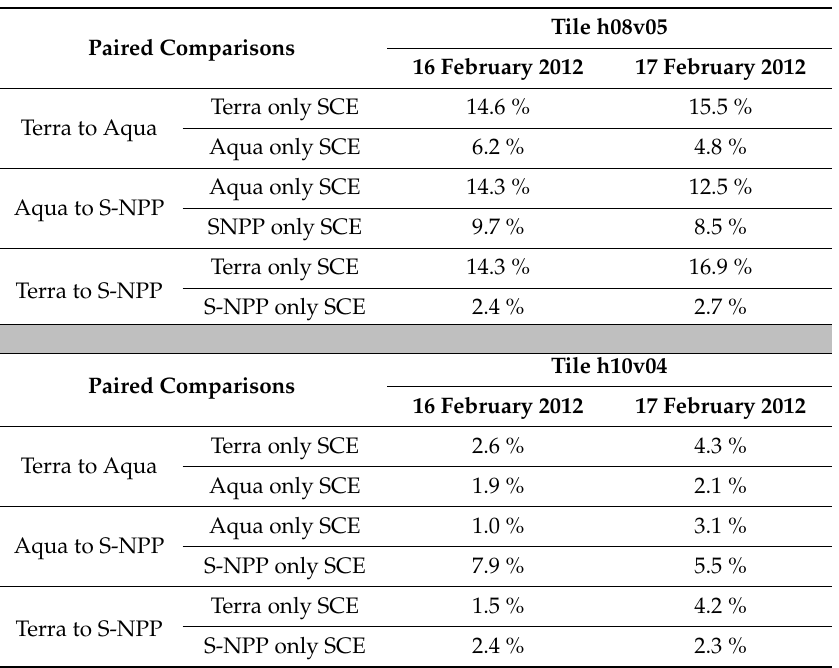
Table 2. Cross comparisons statistics. The percentage of SCE in only one product as compared to the other based on the SCE common to both products is